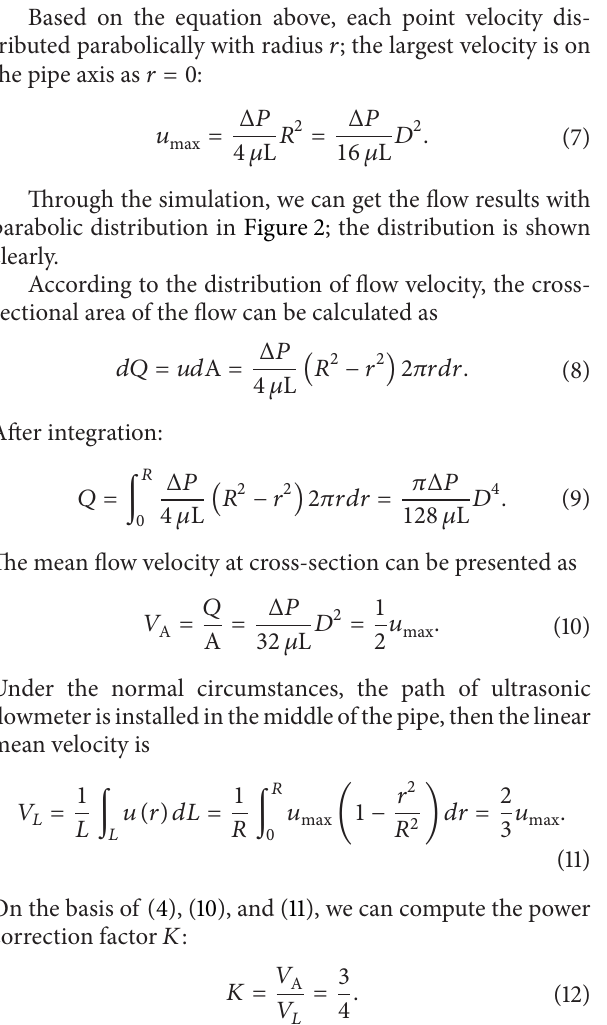
the horizontal direction. Presume that the pressure drop on the pipe is Δ𝑃 and the radius of the pipe 𝑅 = 𝐷/2 , the velocity